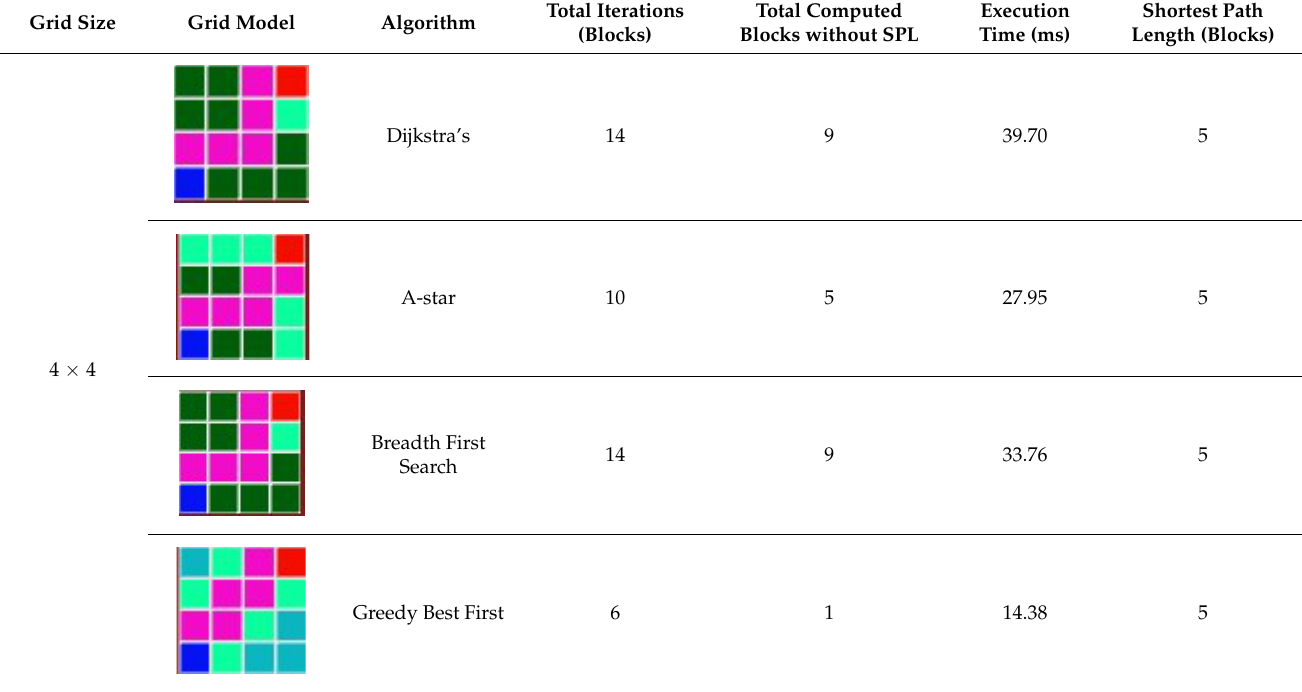
Table 3. Performance analysis of pathfinding Algorithms without obstacles.